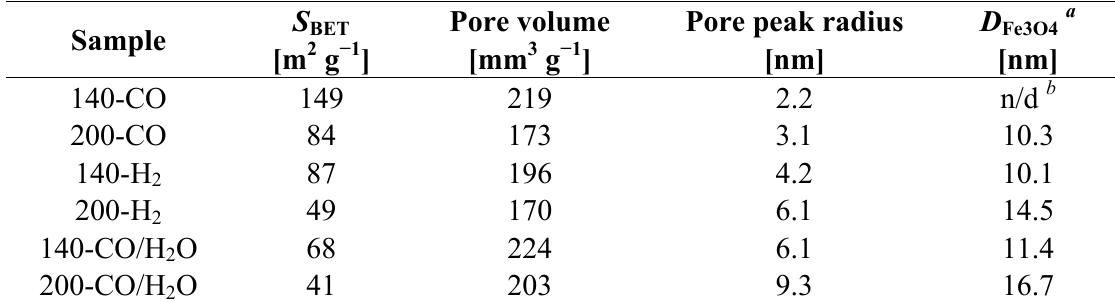
Table 2. Structural properties of the reduced